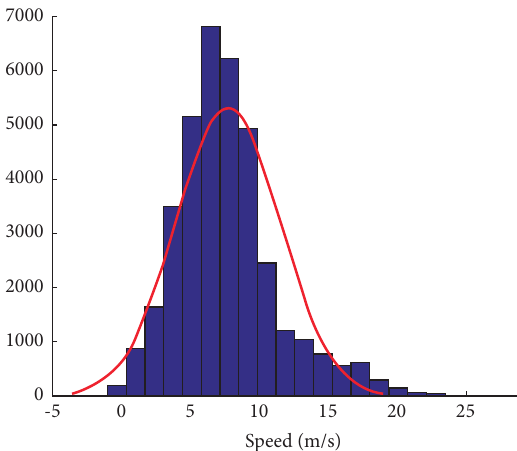
Figure 6: Te distribution of speed.